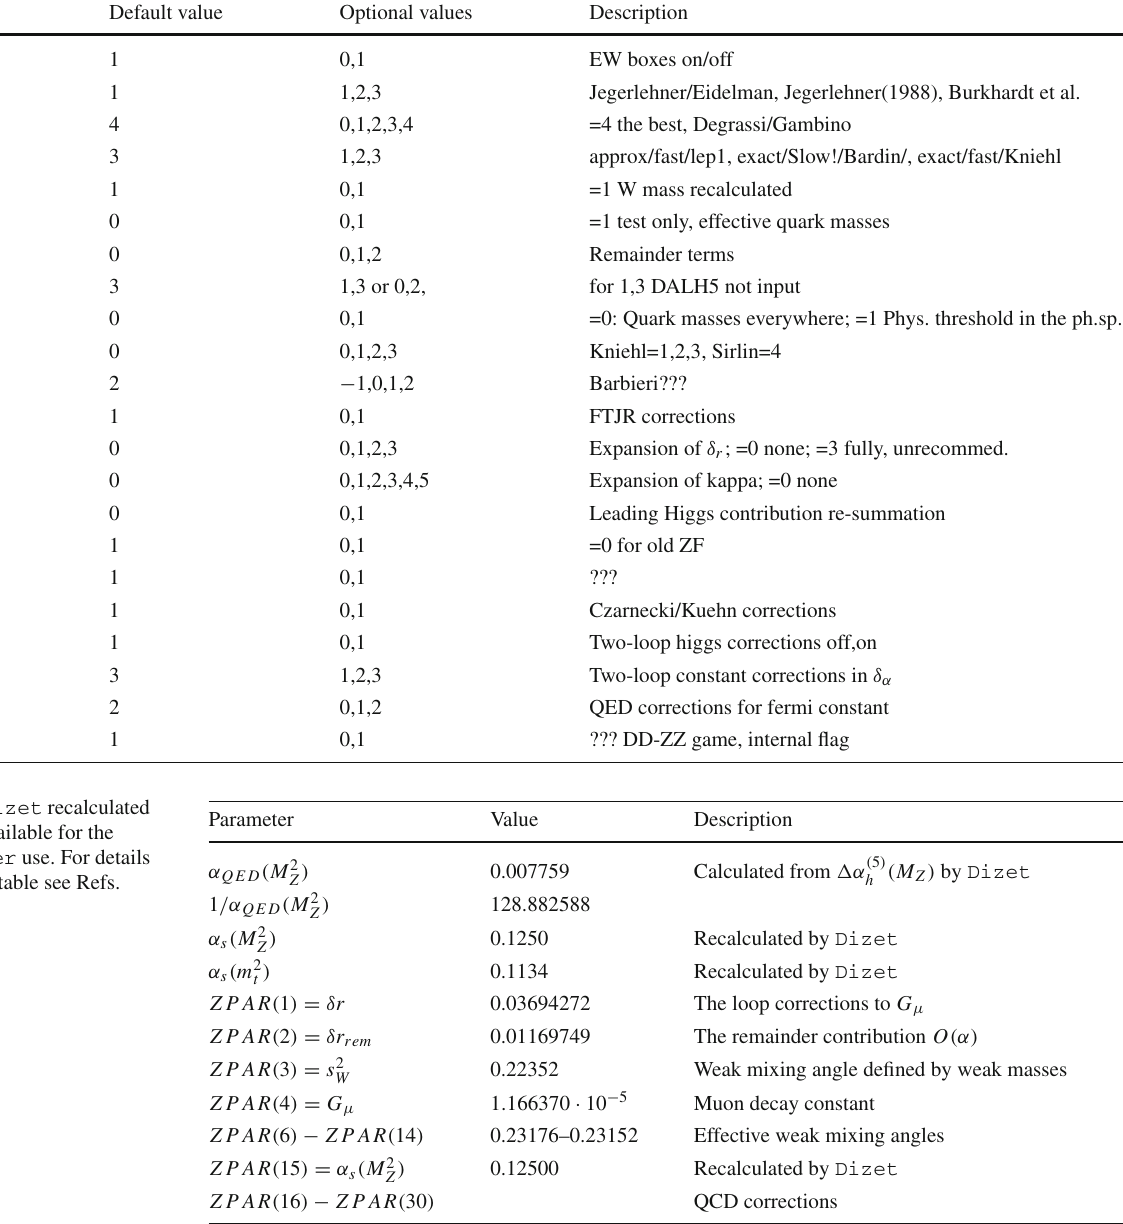
Table 11 Dizet initialization flags. Unmodified comments taken from the KKMC code